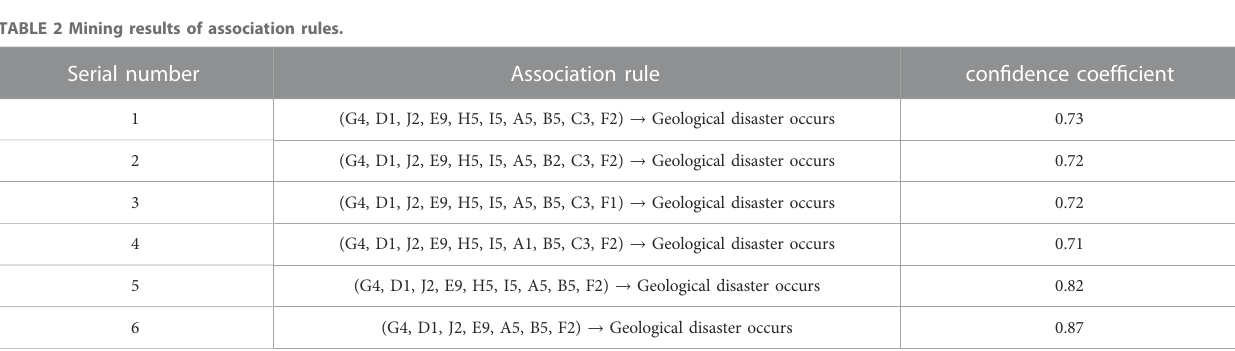
TABLE 2 Mining results of association